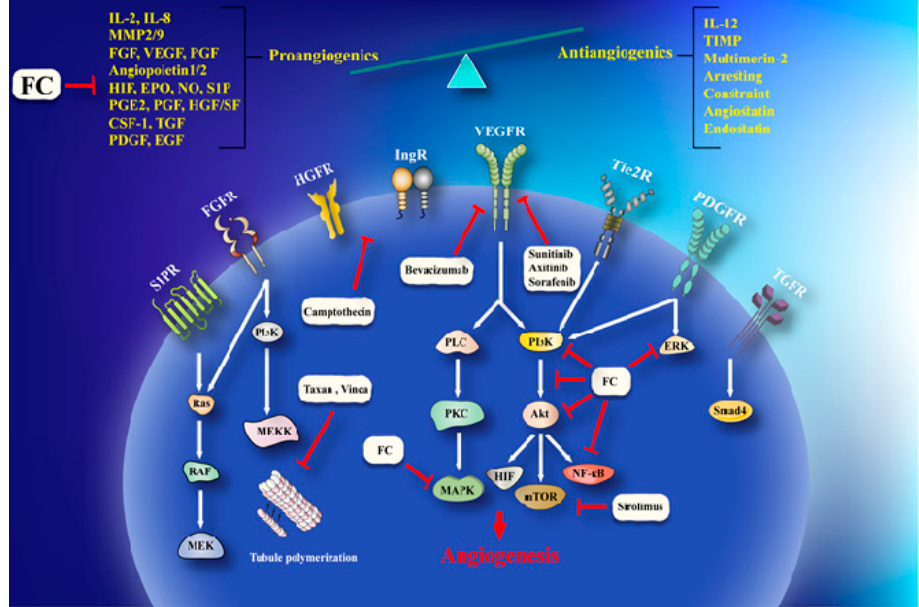
Figure 2. A schema of anti-angiogenesis effects of furanocoumarin. FC via activation/inhibition of a sequences of cellular and molecular pathways exerts its anti-angiogenesis effects. Black lines: induce, sequences of cellular and molecular pathways exerts its anti-angiogenesis e ff ects. Black lines: induce, and red lines: inhibit. and red lines: